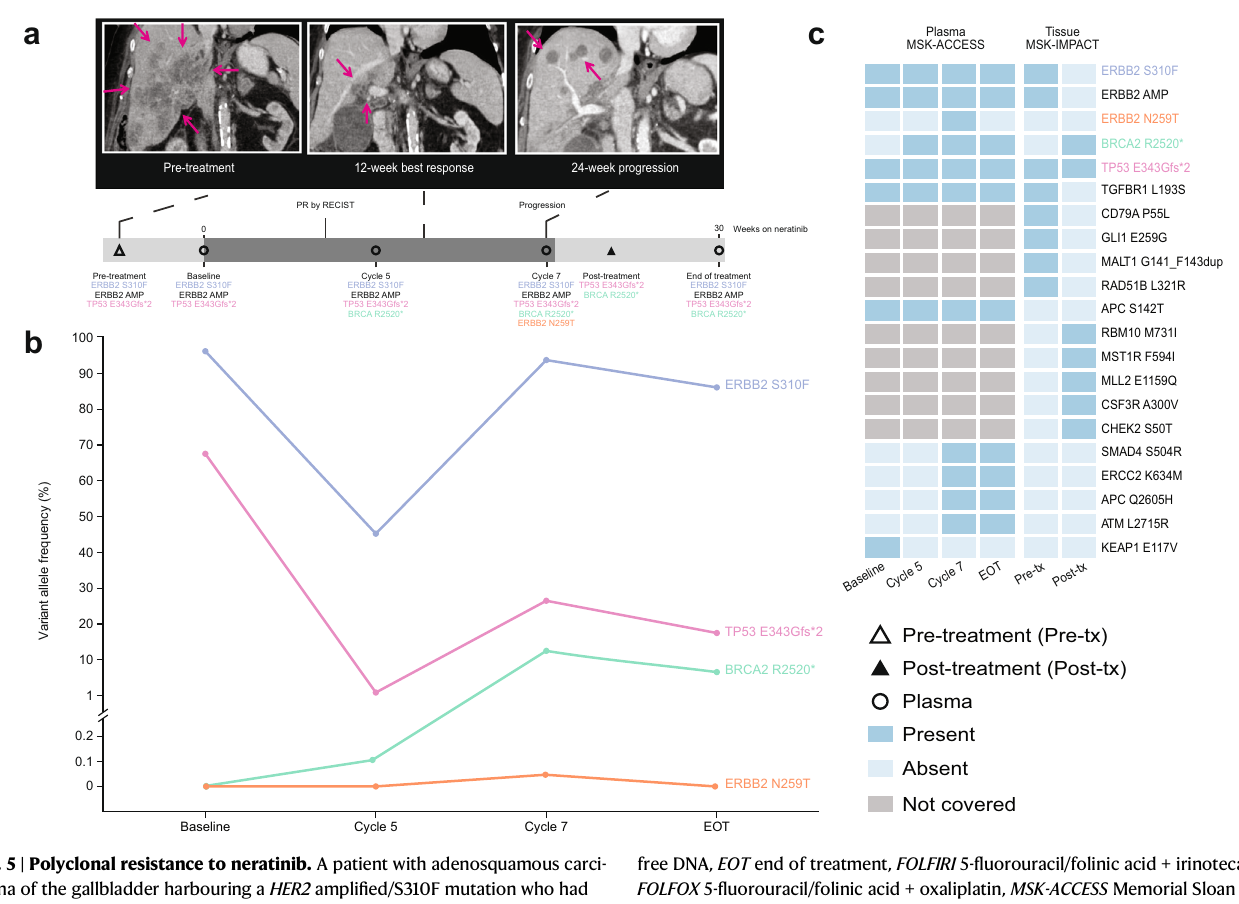
free DNA, EOT end of treatment, FOLFIRI 5- fl uorouracil/folinic acid + irinotecan, FOLFOX 5- fl uorouracil/folinic acid + oxaliplatin, MSK-ACCESS Memorial Sloan Kettering-Analysis of Circulating cfDNA to Evaluate Somatic Status, MSK-IMPACT Memorial Sloan Kettering-Integrated Mutation Pro fi ling of Actionable Cancer Tar- gets, PR partial response, tx treatment. Source data are provided as a Source Data fi